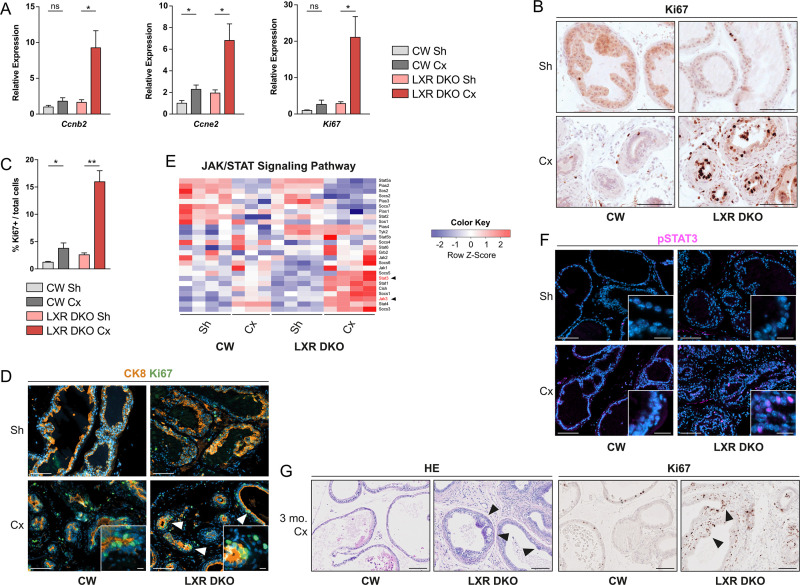
Castration-induced chronic inflammation promotes prostate neoplasia development in LXR-null mice.(A) RT-qPCR analysis of cyclins genes Ccnb2 and Ccne2 and Ki67 proliferation marker gene. (B and C) Immunohistochemical detection of Ki67 proliferation marker (B) and proliferation index of prostate in Sh or 1-month Cx mice (C). (D) Proliferation marker Ki67 colocalization with epithelial cells marker CK8 demonstrates high proliferation capacities of 1-month Cx LXR DKO prostate. (E) RNA sequencing analysis of JAK/STAT signaling pathway genes expression. (F) Histological analysis of phospho-STAT3 in CW and LXR DKO prostates following 1-week castration. (G) After 3 months of castration, highly proliferative lesions seen in response of 1 month of castration in LXR-null prostates progress to neoplastic PIN lesions as demonstrated by hematoxylin and eosin staining and Ki67 immunohistochemical detection. Groups are composed of at least 4 animals. Bars represent mean ± SEM. Statistical analyses were performed via Mann–Whitney test. *p < 0.05, **p < 0.01, ***p < 0.001 and ns. Scale bars, 100 μm; insets, 10 μm. For numerical raw data, please see S1 Data. For supporting dataset, please see S2 Data. Cx, castrated; CW, control wild-type; JAK/STAT, Janus kinase/signal transducers and activators of transcription; LXR, liver X receptor; LXR, liver X receptor; LXR DKO, LXR alpha and beta double knock-out; ns, nonsignificant; PIN, prostatic intraepithelial neoplasia; RT-qPCR, quantitative reverse transcription PCR; Sh, sham-operated.